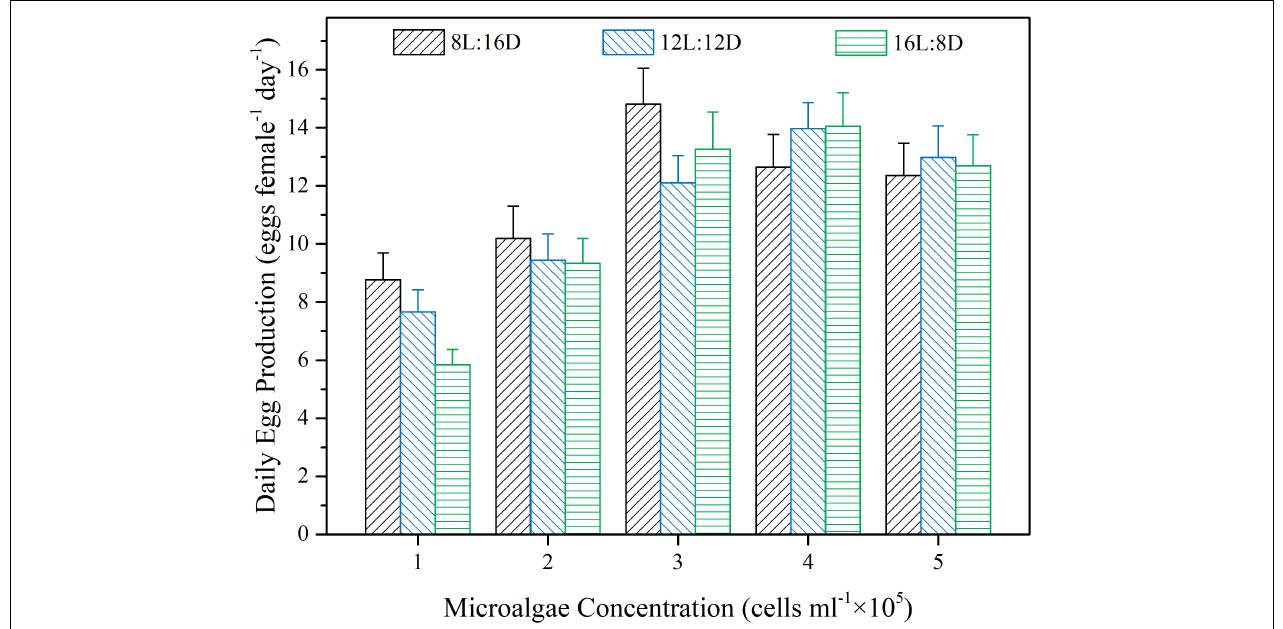
FIGURE 1 | Effects of different concentrations of the microalgal diet and photoperiods on average daily egg production of Bestiolina amoyensis ( N = 12). Data is presented as mean ± standard error (SE).